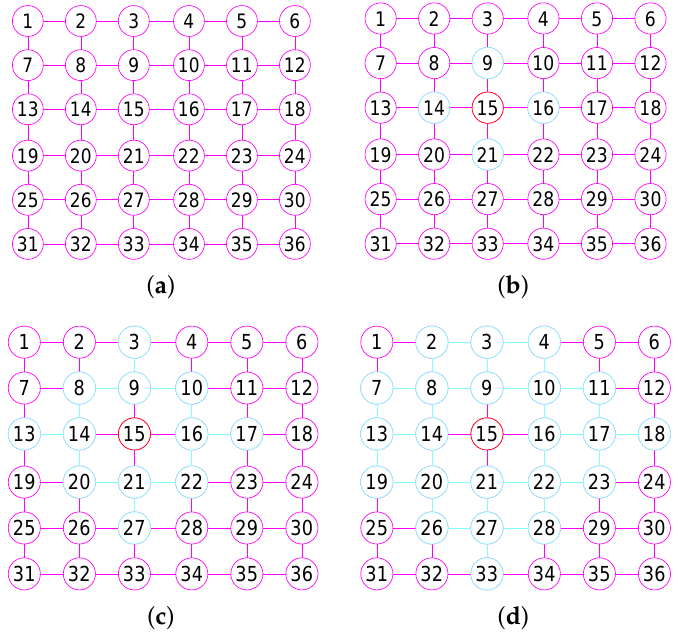
Figure 2. The 1, 2, 3-neighborhood subgraph of vertex 15 in the 6 × 6 grid graph G 6,6 . ( a ) The 6 × 6 grid graph G 6,6 ; ( b ) The 1-neighbor subgraph of 15; ( c ) The 2-neighbor subgraph of 15; ( d ) The 3-neighbor subgraph of